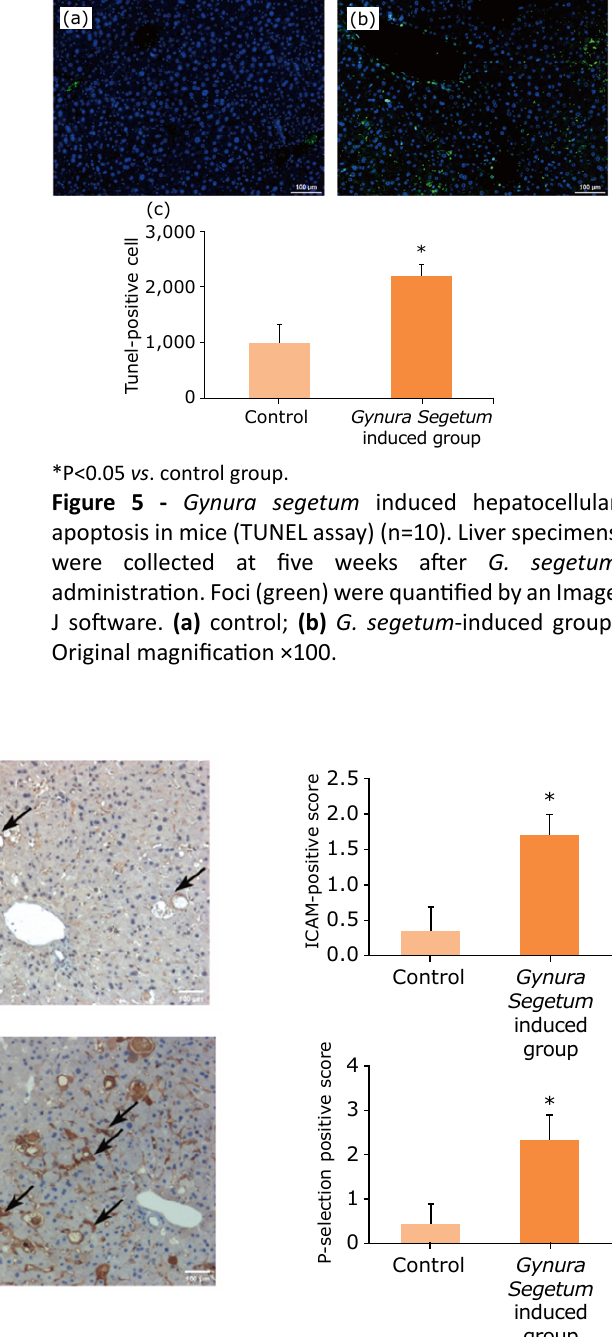
after G. segetum administration, high expression levels of ICAM-1 and P-selectin in endothelial cells were observed in G. segetum treated mice.